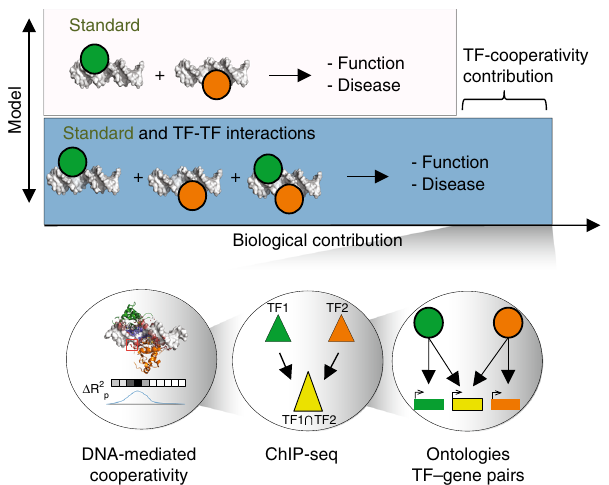
Fig. 7 Model to estimate cooperative TF-binding biological contribution to TF-ontology associations. Illustration of different types of models that describe associations of TF with function and disease (top). The Standard model describes the biological contribution of single TF-DNA binding, which can be improved by the addition of TF – TF interactions for an enhanced understanding of function and disease. This is translated into an overall increased discovery of strong phenotypes associated to TFs when acting in combination. Information used in this work to describe TF cooperativity and reveal TF-cooperativity linked processes (bottom) (DNA- mediated cooperativity = TF – TF k -mers and prioritization of important binding modes; ChIP-seq = co-occupied peaks for TF pairs; ontologies and TF-gene pairs = associations between co-occupied regions by TF pairs and their associated genes, linked to function through ontology